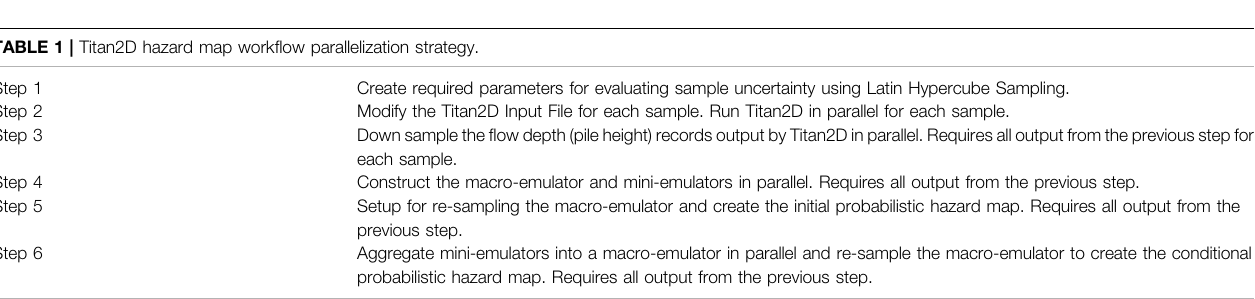
TABLE 1 | Titan2D hazard map work fl ow parallelization